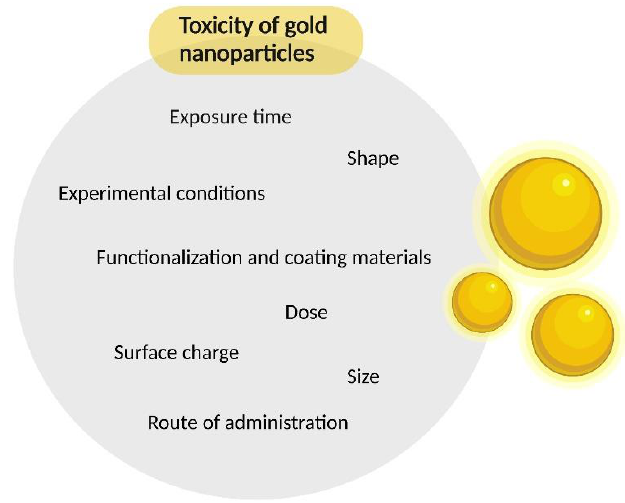
Figure 1. Factors influencing the toxicity of gold nanoparticles.